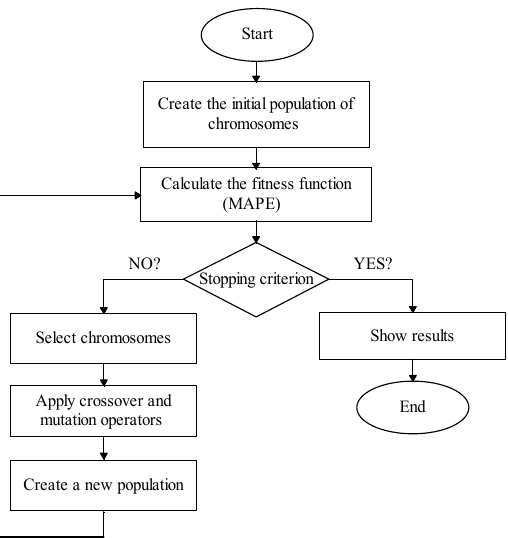
Figure 3. The main steps of the genetic algorithm.